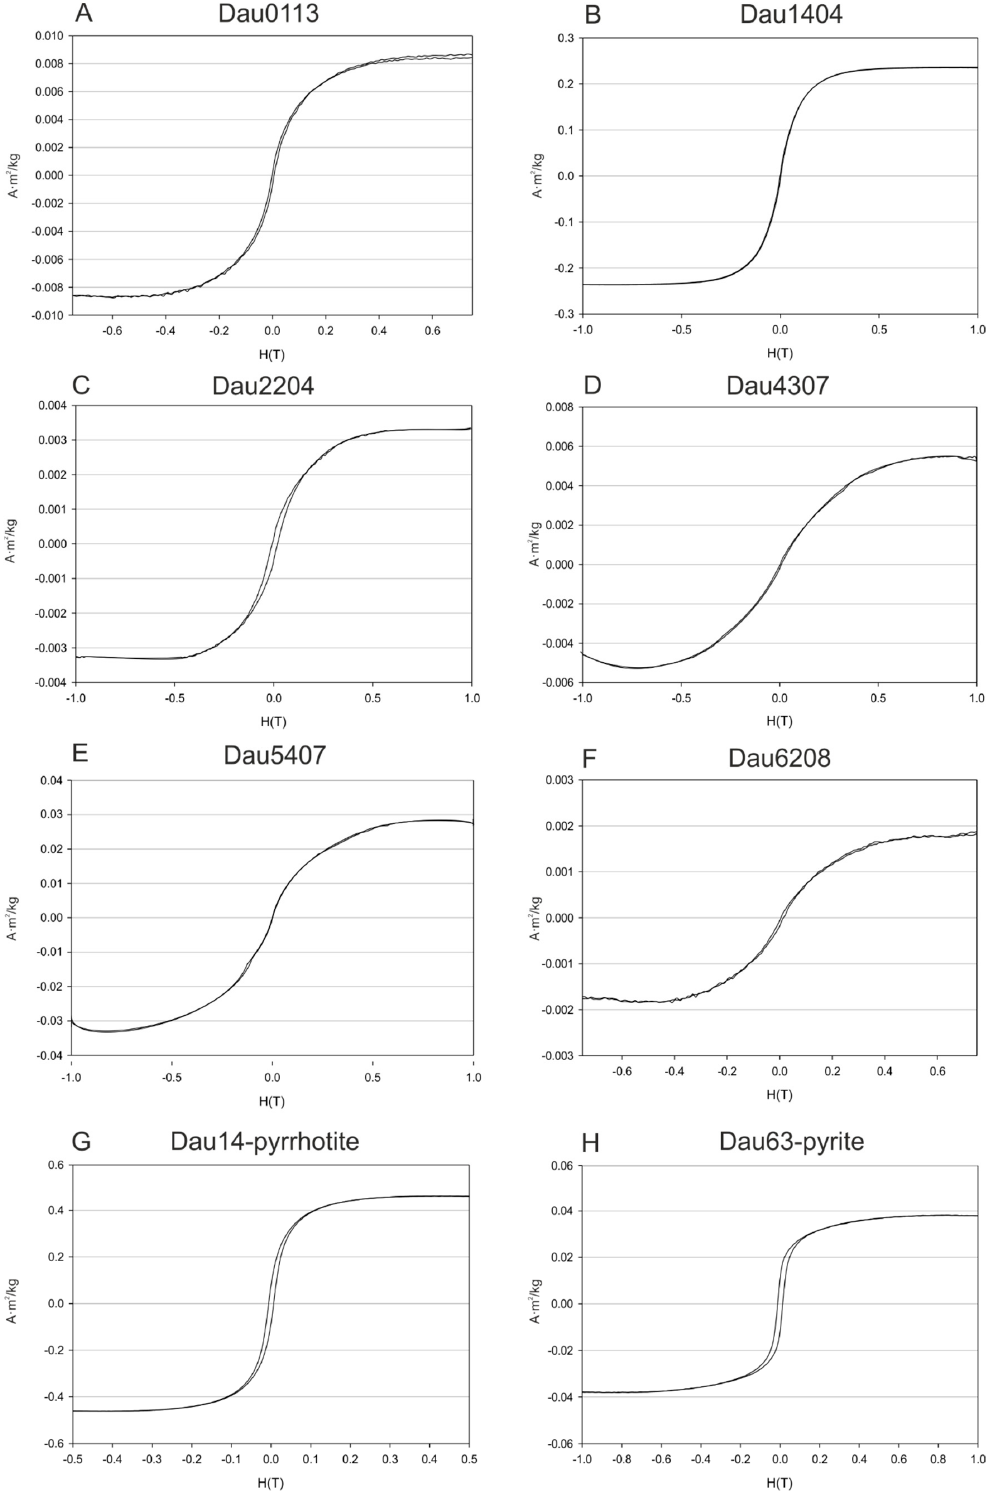
Figure 6. Examples of hysteresis loops of “whole-rock” samples ( A – F ) and separated magnetic fraction ( G , H ) of metadolerites from SW Oscar II Land.